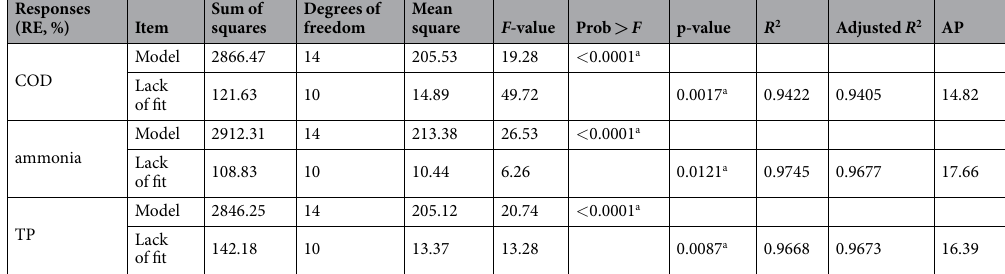
Table 2. ANOVA results for the three responses. a Significant AP: adequate precision; R 2 : determination coefficient; Adjusted R 2 : adjusted determination